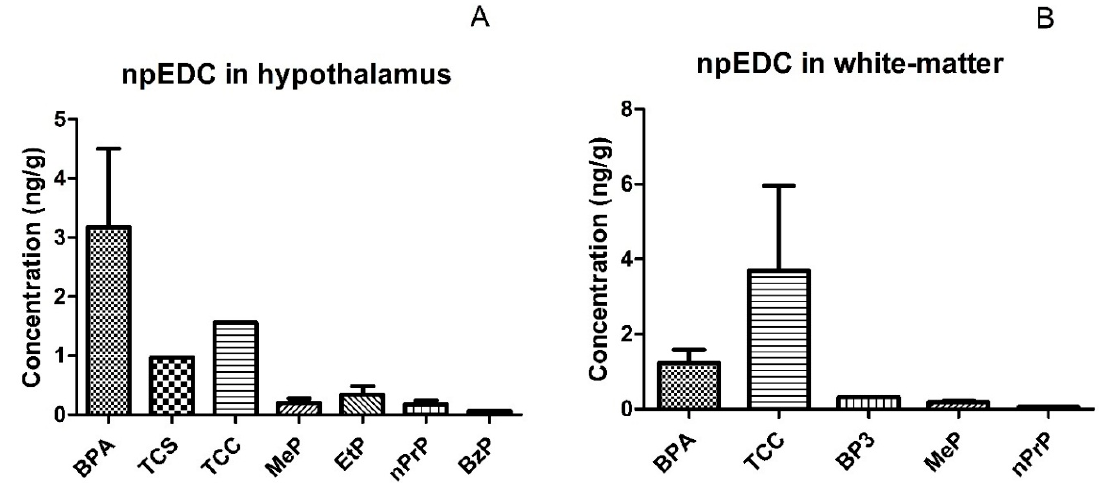
Figure 1. Measured concentrations (mean ± SD) of npEDC in hypothalamus, n = 24 ( A ) and white-matter brain tissue, n = 12 ( B ). Abbreviations: BPA: bisphenol A; BP-3: benzophenone-3; TCC: triclocarban; TCS: triclosan; MeP: methylparaben; EtP: ethylparaben; npEDCs: non-persistent endocrine disrupting chemicals; n-PrP: n-propylparaben; BzP: benzylparaben; SD: standard deviation.